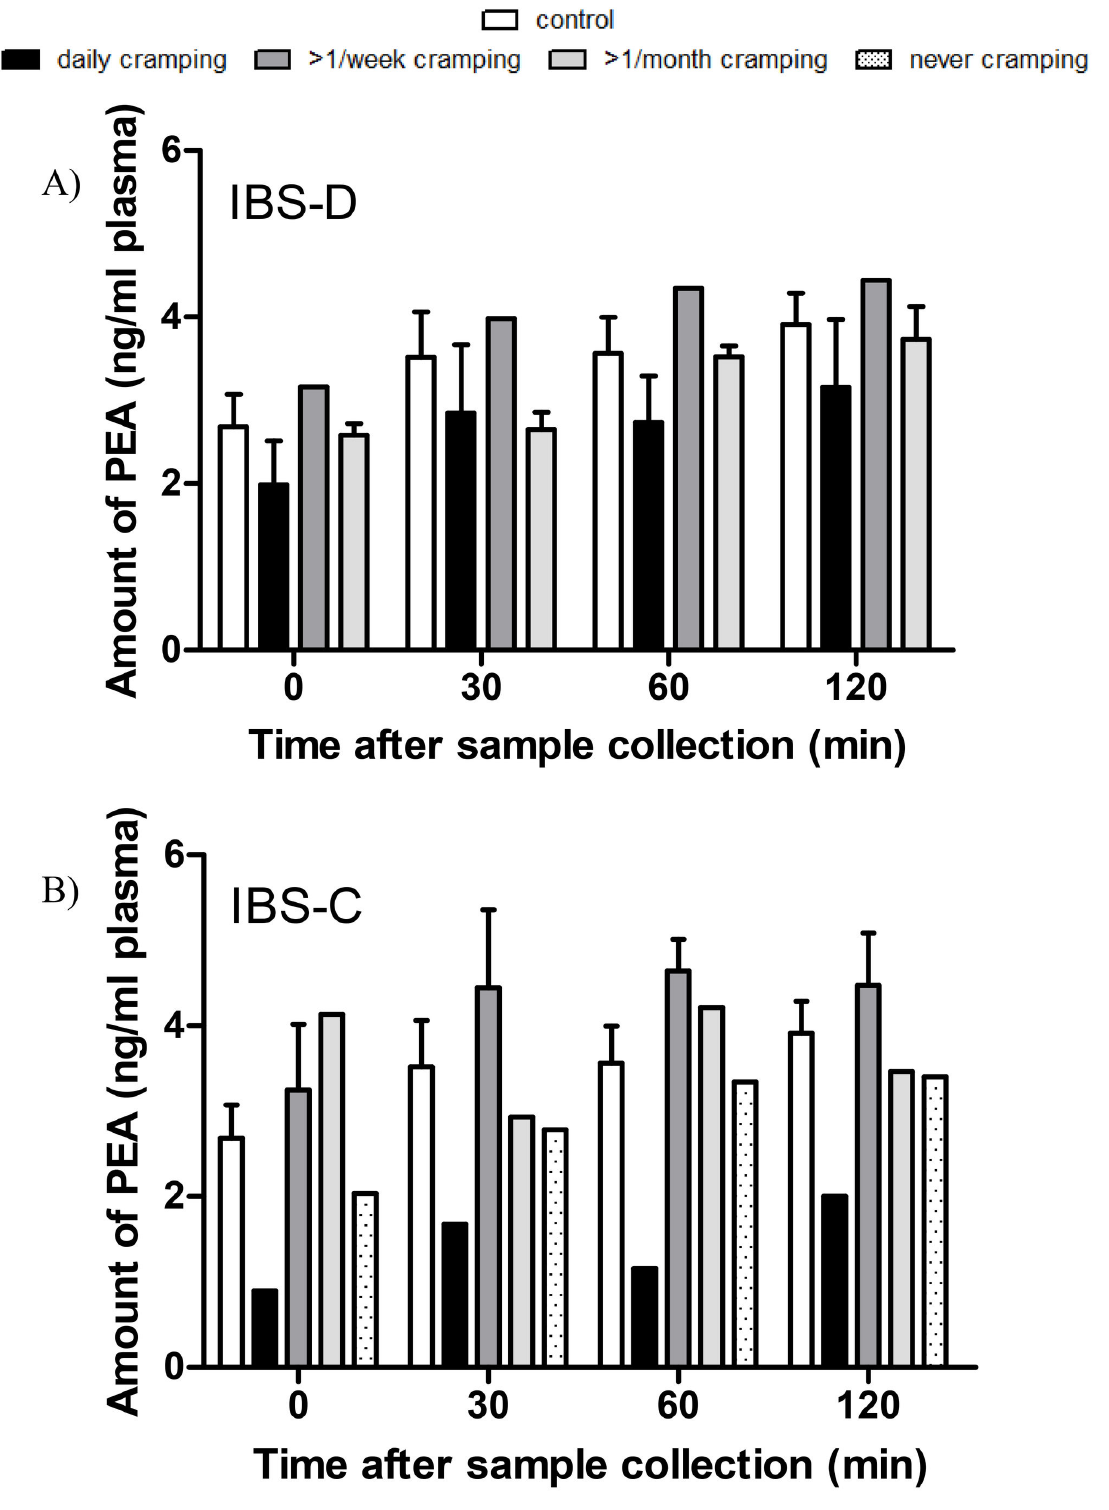
Figure 2. PEA levels in plasma from IBS patients. PEA levels in plasma 0, 30, 60 and 120 min after blood sample collection from IBS-D (A) and IBS-C (B) patients vs. abdominal cramping frequency. The results are shown as mean ± SEM of n=7 for each group. Each sample was run in triplicate. doi: 10.1371/journal.pone.0085073.g002 PLOS ONE |